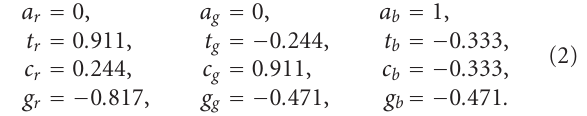
encoded in color. The colors for the nucleotides A , T , C , and G are blue, red, green, and yellow, respectively. These colors were chosen to optimize the discrimination between di ff erent nucleotides. As a rule of thumb, the interaction be- tween the various nucleotides is visualized as the superpo- sition of colors representing those nucleotides. Thus, a se- quence composed of ATATAT ... would have a purple bar at the frequency corresponding to period 2. The first spec- trogram (Figure 1) shows a spectrogram created from a se- quence of 60000 “totally random” nucleotides. The sequence was created from an independent identically and uniformly distributed random sequence model so that every position has equal chance of being an A , T , C , or G . No obvious patterns are noticeable. The second spectrogram (Figure 2) shows the same sequence as the first but with a